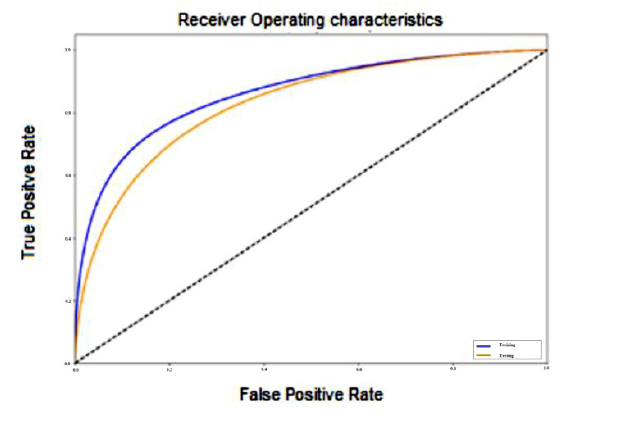
Figure 4. Receiver Operating Characteristic Curve